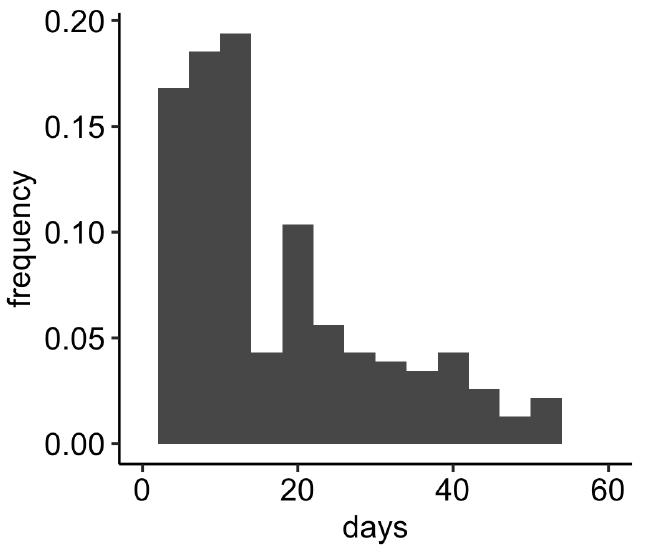
Figure 4. Frequency histogram of the time elapsed before a change event could be positively identified for all land cover change events. Time elapsed is calculated as the number of days between the last day of confirmed Renosterveld presence and the first day of confirmed